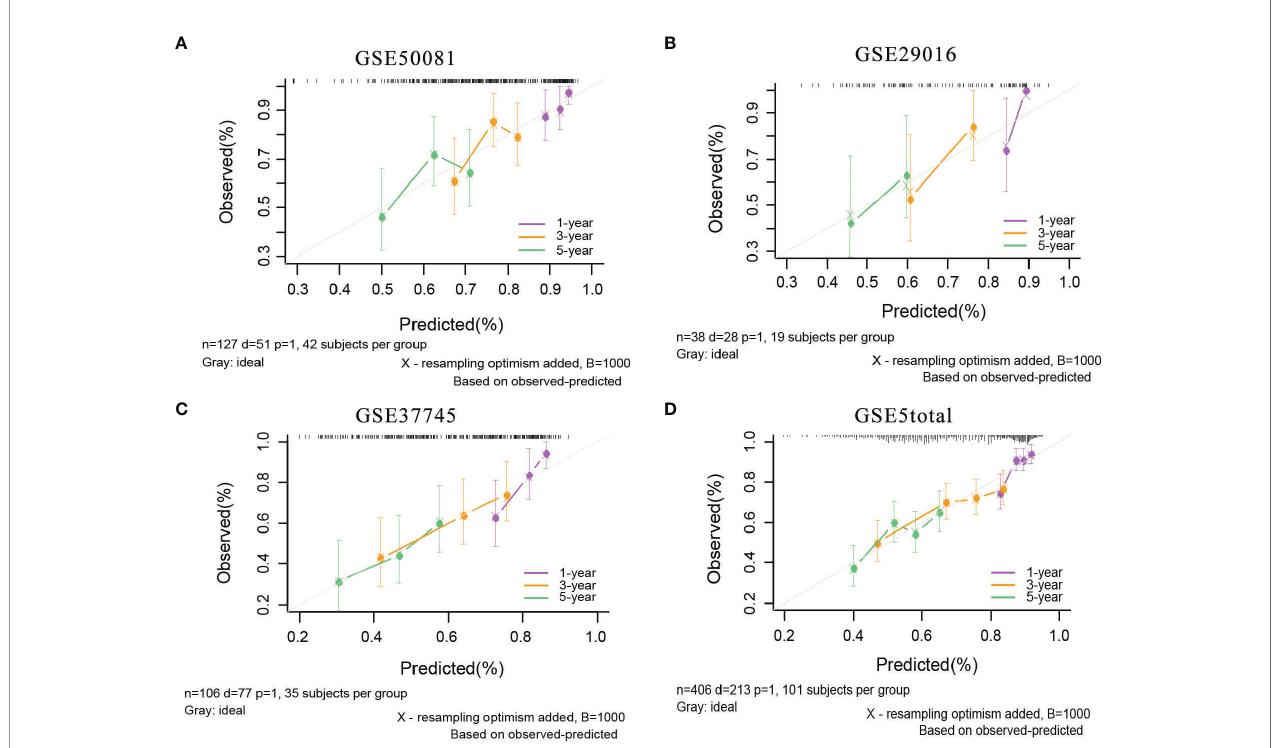
FIGURE 6 | The calibration plots of mRNA model in external validation data sets. (A) GSE50081 dataset. (B) GSE29016 dataset. (C) GSE37745 dataset. (D) GSE5total